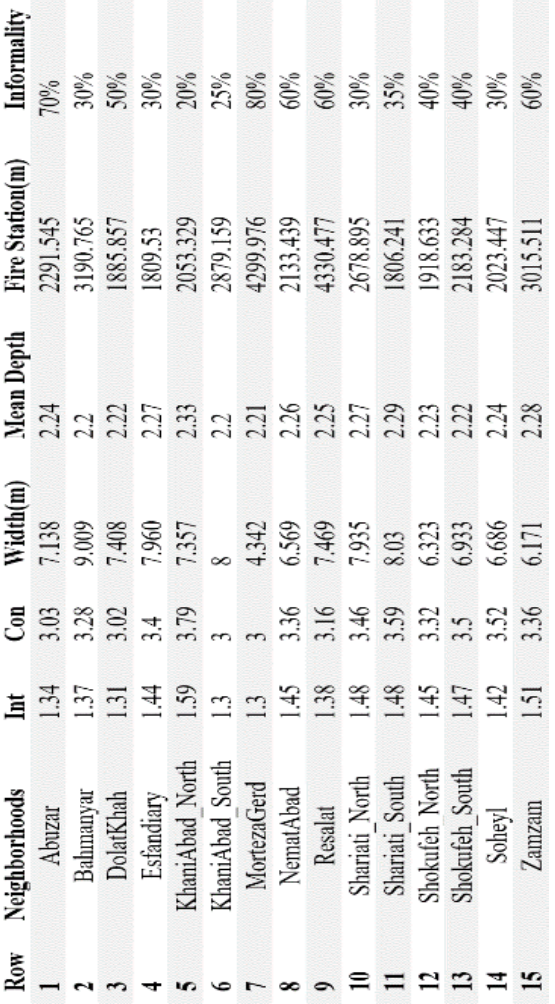
Table 4 . Results of Percent